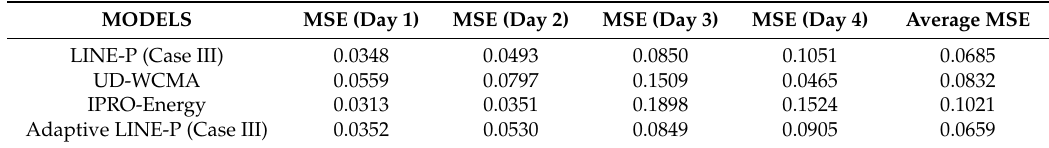
Table 9. Error comparison of the prediction models based on MSE for the SCE solar energy profile.